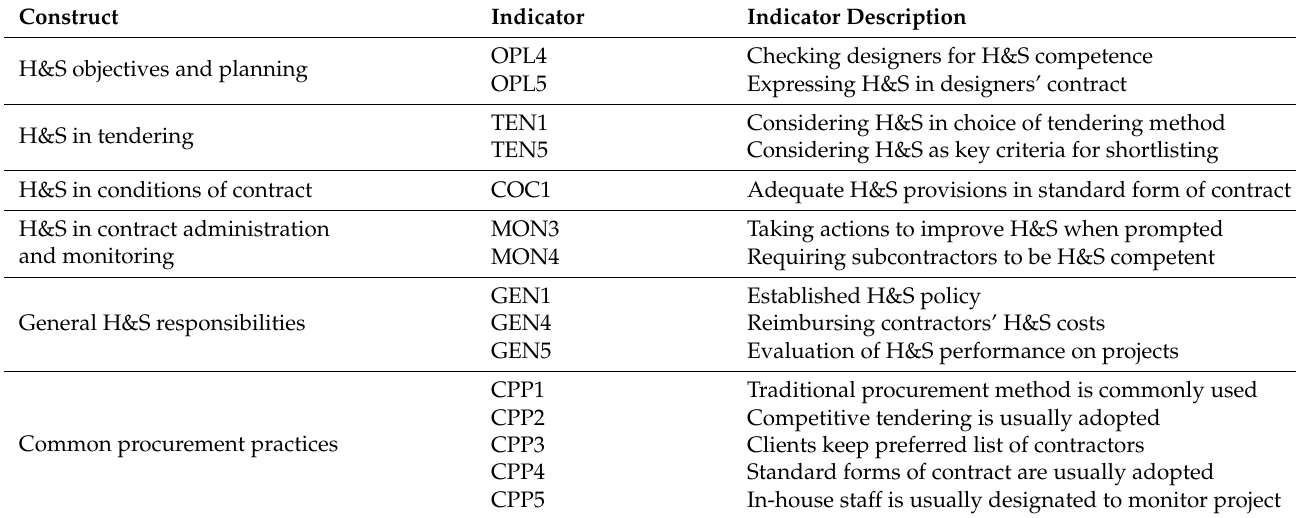
Table 4. Indicators eliminated due to poor